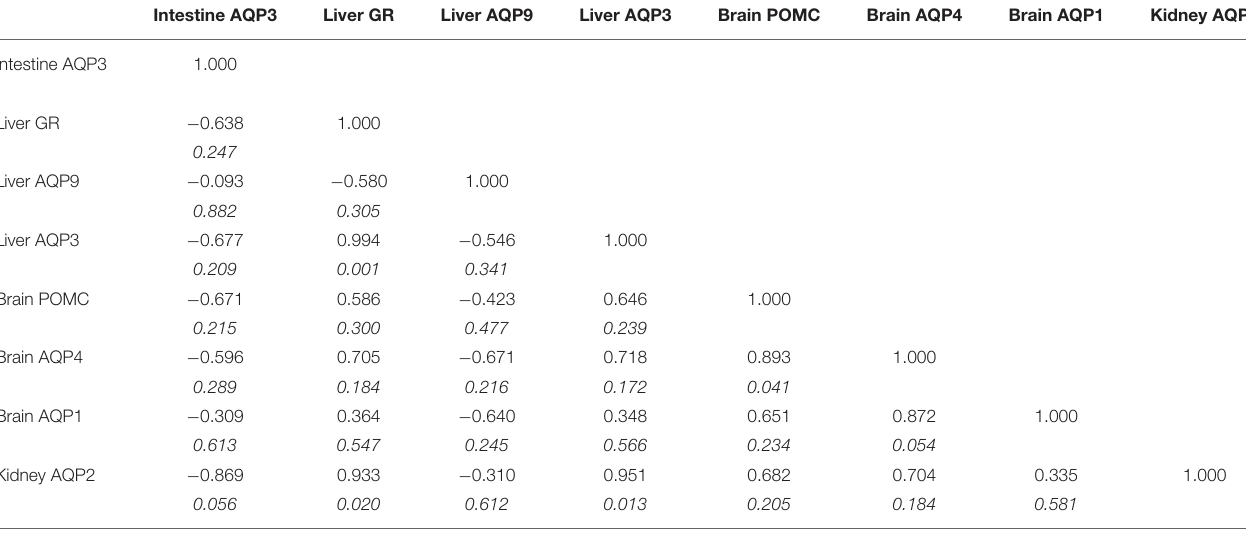
TABLE 5 | The correlation coefficient (r) between different mRNA transcripts means on day-2 1,2 . Intestine AQP3